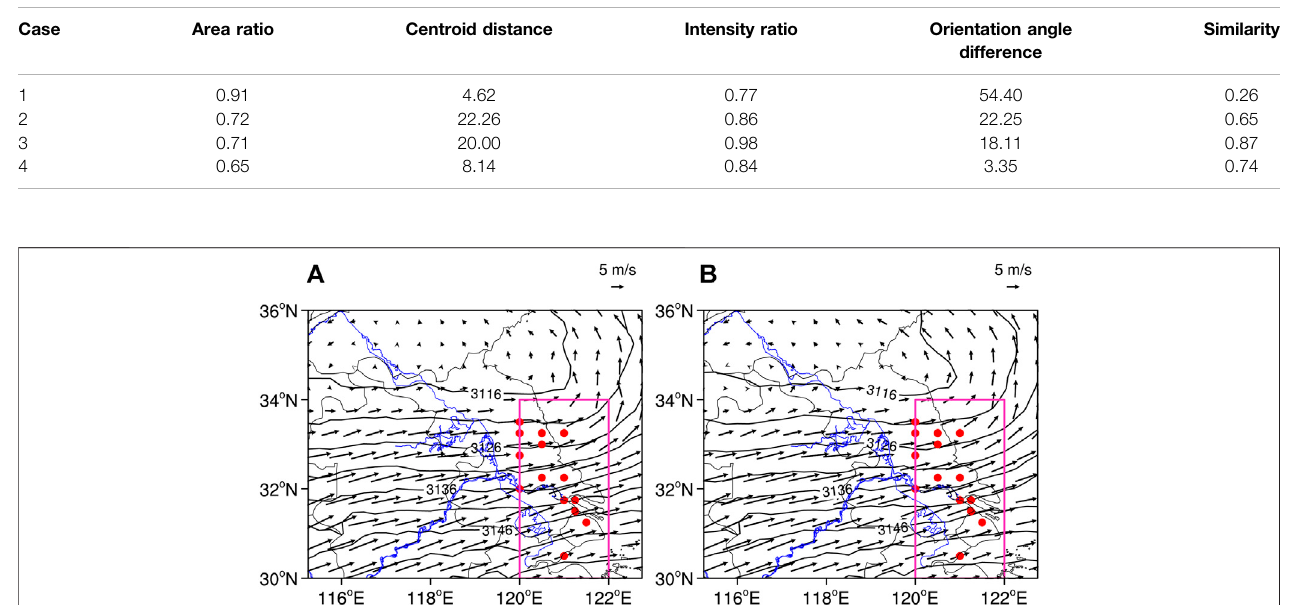
TABLE 4 | Same as Table 3 , but for the lead time of 4 – 6 h.